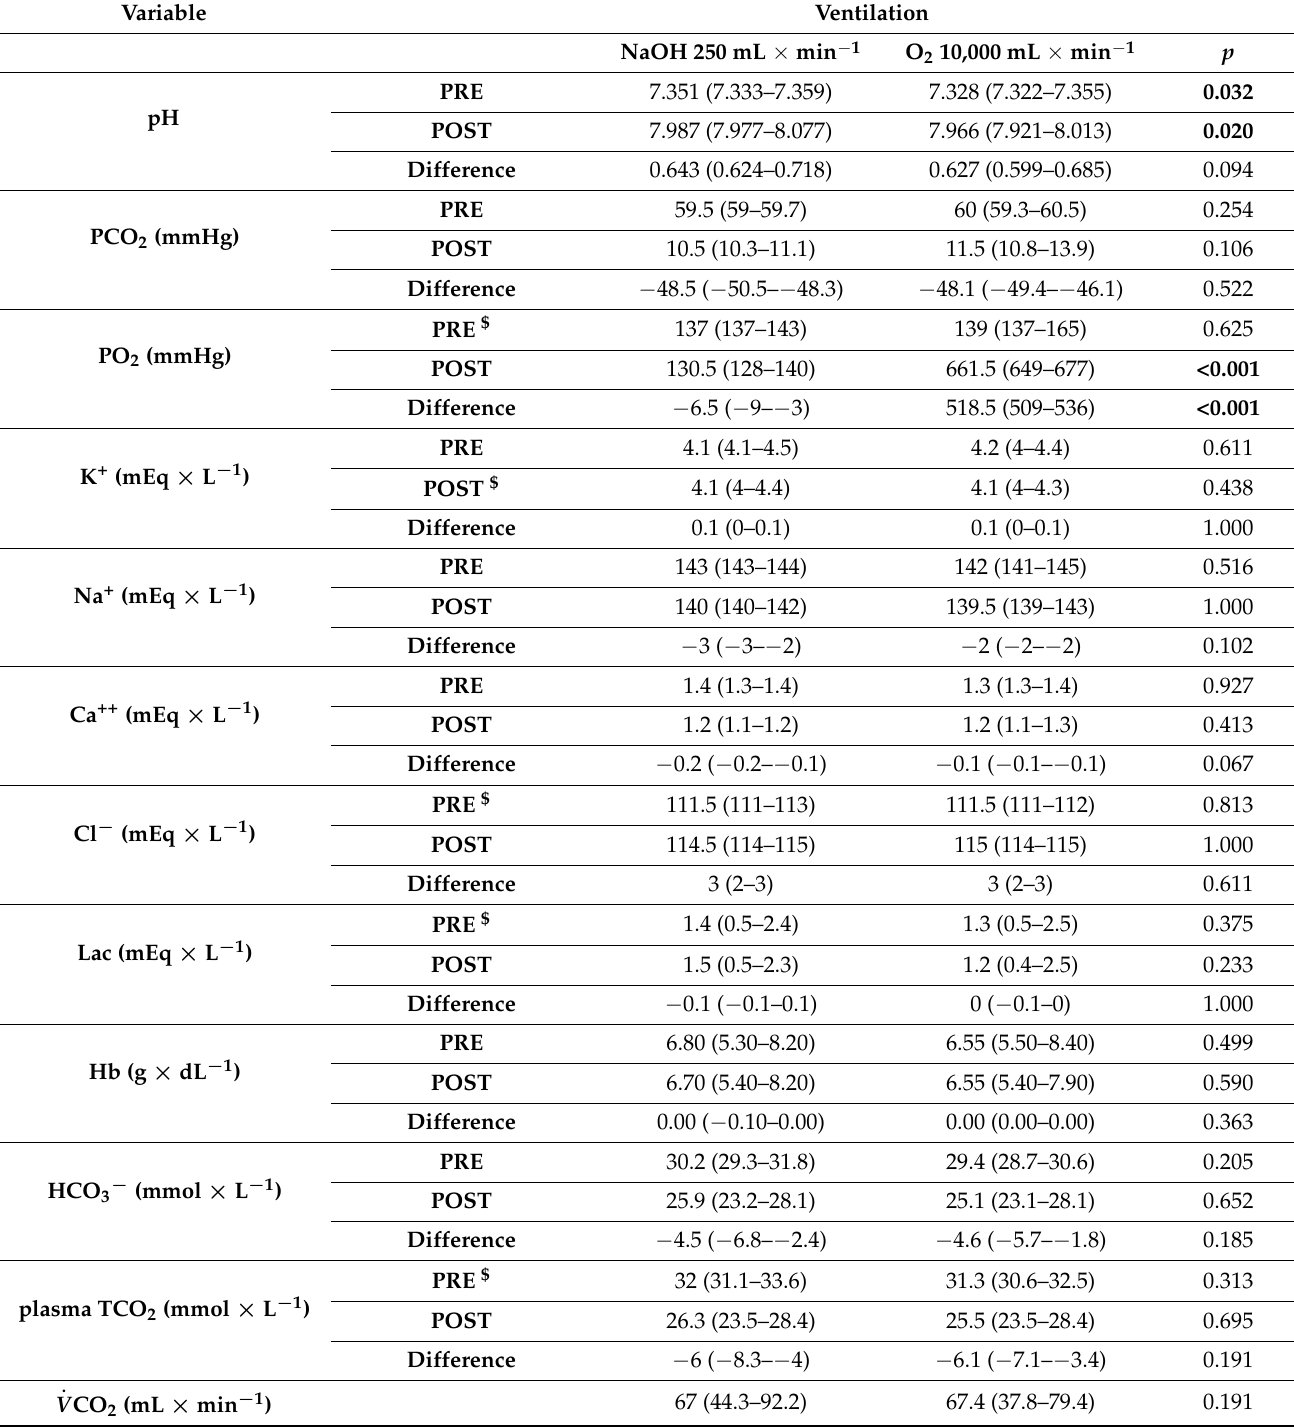
Table 2. Efficacy tests